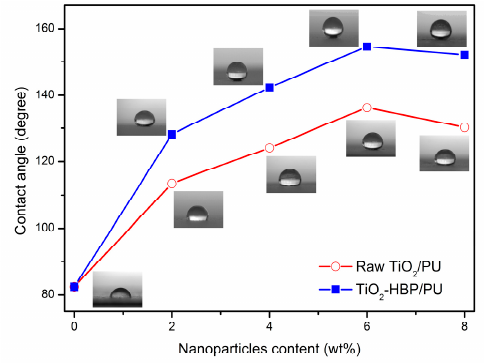
Figure 9. The water contact angle (CA) of nanocomposite coatings.